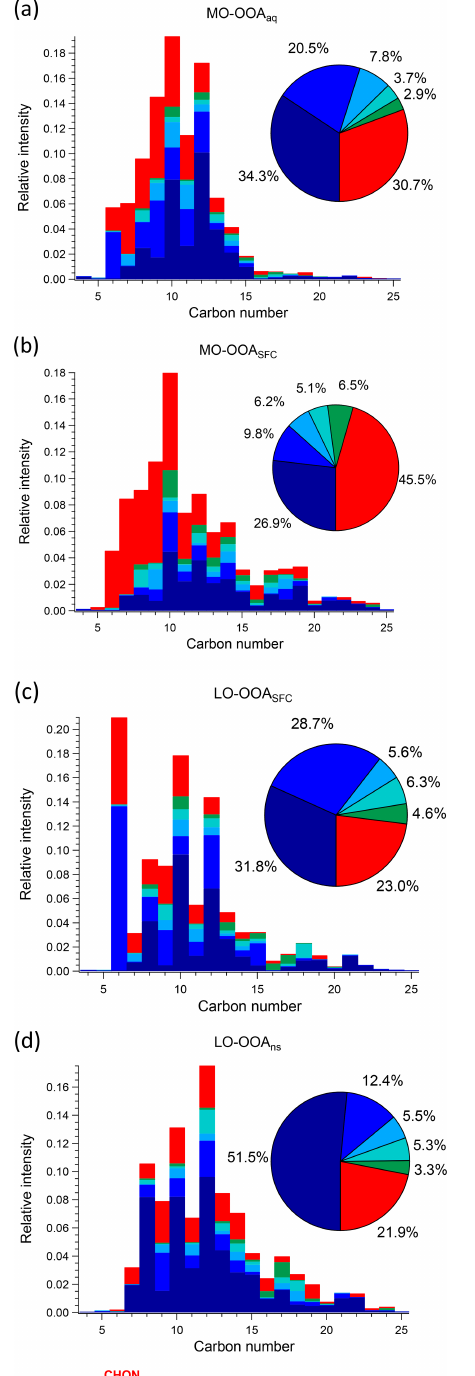
Figure 8. Carbon number distribution plots of four OOA factors: (a) MO-OOA aq , (b) MO-OOA SFC , (c) LO-OOA SFC , and (d) LO-OOA ns , coloured by C x H y O z N 1–2 (red), and five different C x H y O z categories (green to blue) based on O:C ratio (O:C < 0.25, 0.25 < O:C < 0.45, 0.45 < O:C < 0.65, 0.65 < O:C < 0.85 and O:C > 0.85). Each distribution is nor- malised such that its sum is